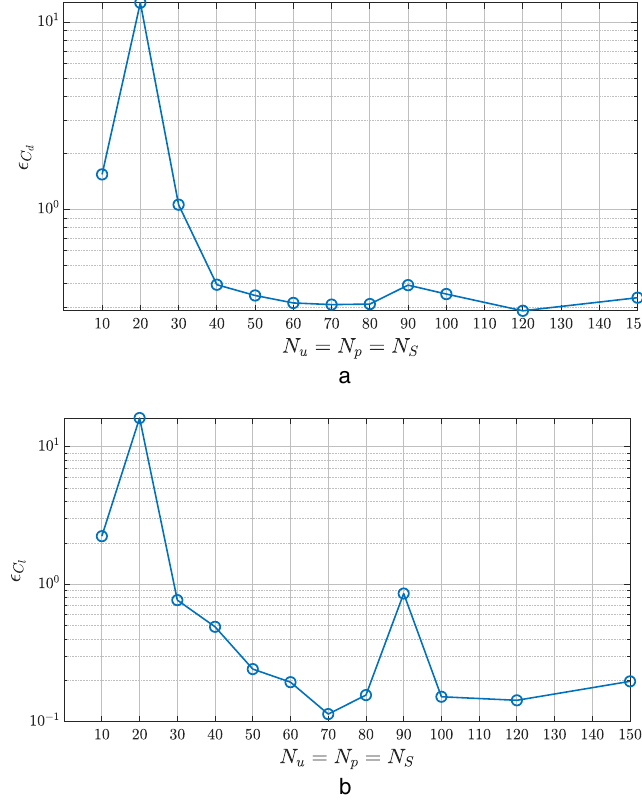
Fig. 18 The L 2 relative errors for the approximation of the drag and lift coefficients in the time span [100 , 150] as function of the number of modes. A base-10 logarithmic scale on the y -axis is used in both plots, the error values are already in percentages. (a) The L 2 relative error in approximating the drag coefficient C d over the time span [100,150] as function of the number of modes. (b) The L 2 relative error in approximating the lift coefficient C l